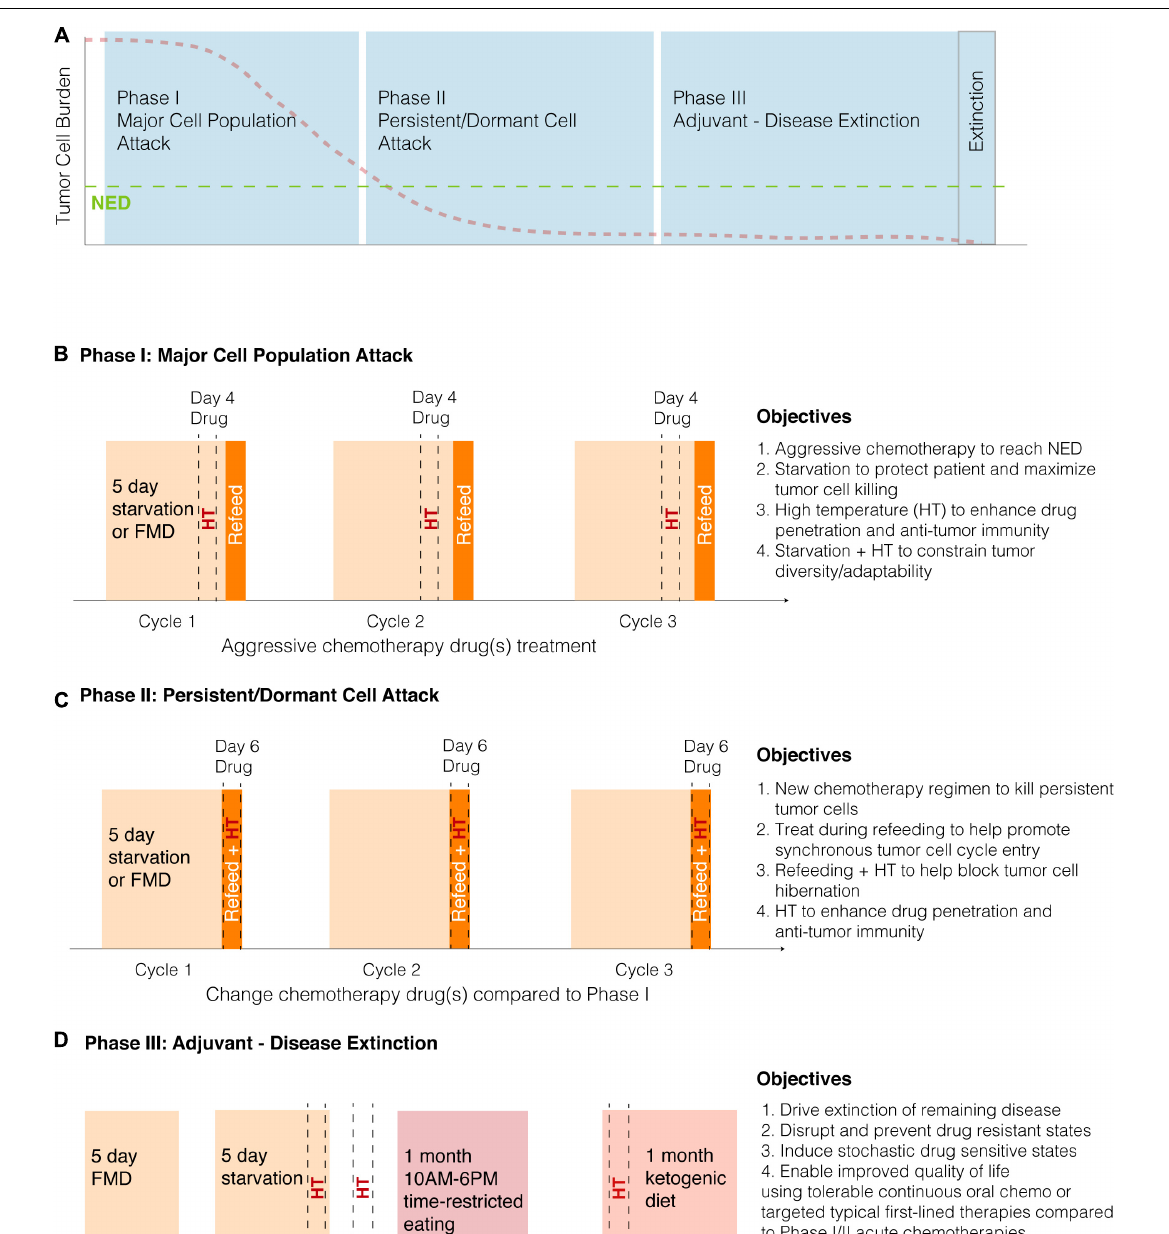
Frontiers in Ecology and Evolution |